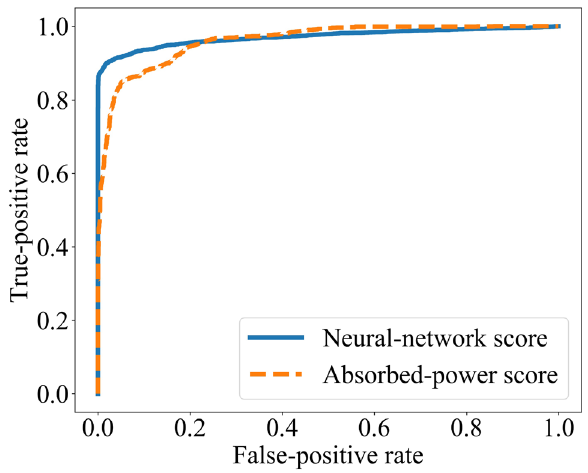
Figure 7. Receiver-operating-characteristic (ROC) curve: The spin glass was trained with three drives, then tested with a familiar drive or with a novel drive. From a response of the system’s, an ROC curve can be defined. The blue, solid curve is defined in terms of a bottleneck neural network; and the orange, dashed curve is defined in terms of absorbed